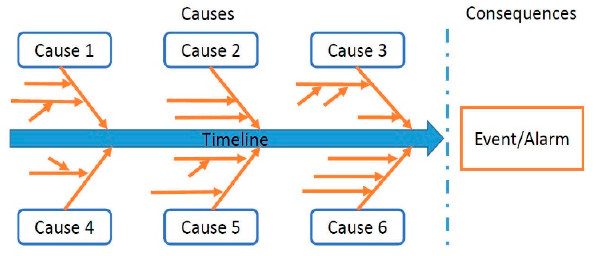
Figure 4. Event cause–consequence diagram.